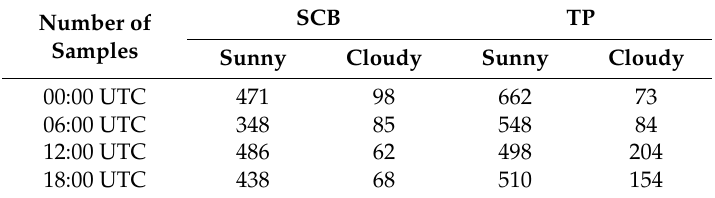
Table 3. The number of samples on sunny/cloudy days in the Sichuan Basin (SCB) and in the TP for summertime during five